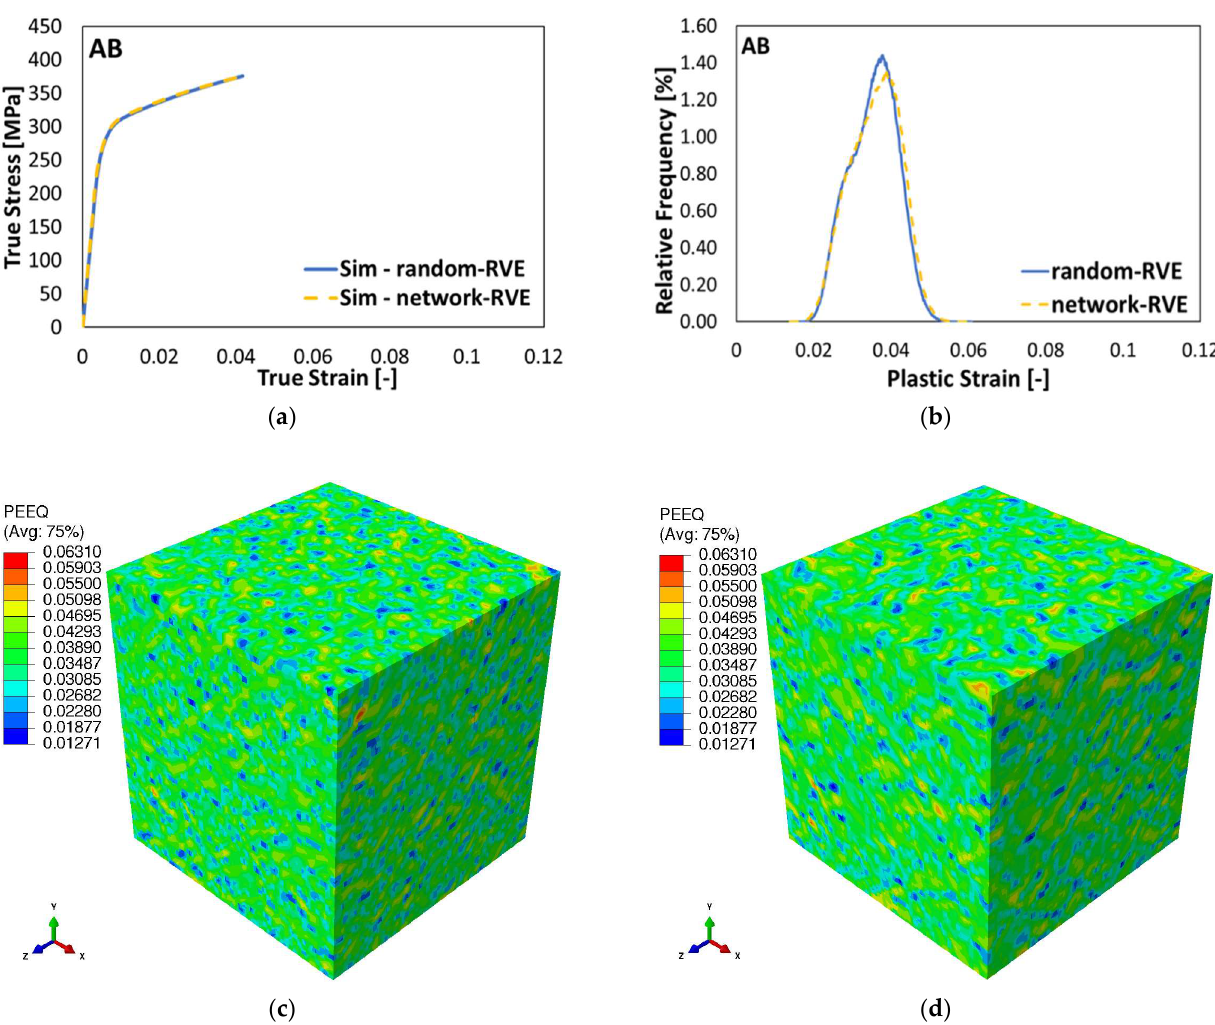
Figure 10. Effect of the approach used for modeling of the Si-rich phase, ( a ) macroscopic stress–strain curves, ( b ) relative frequency of the prevailing microscopic plastic strain, and ( c , d ) equivalent plastic strain distribution of the random RVE and network RVE, respectively.